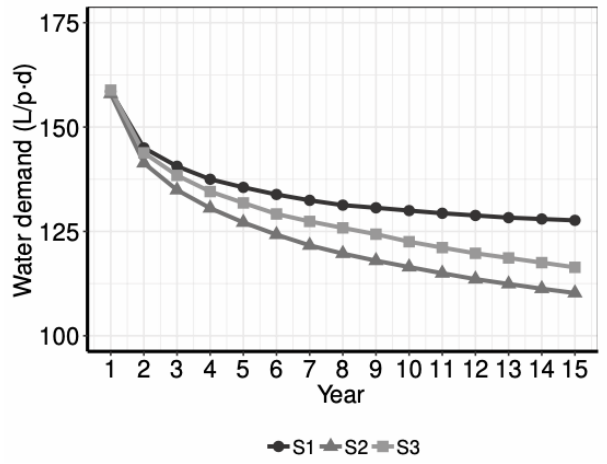
Table 6. Scenario outcomes at the end of the simulation (15 years).